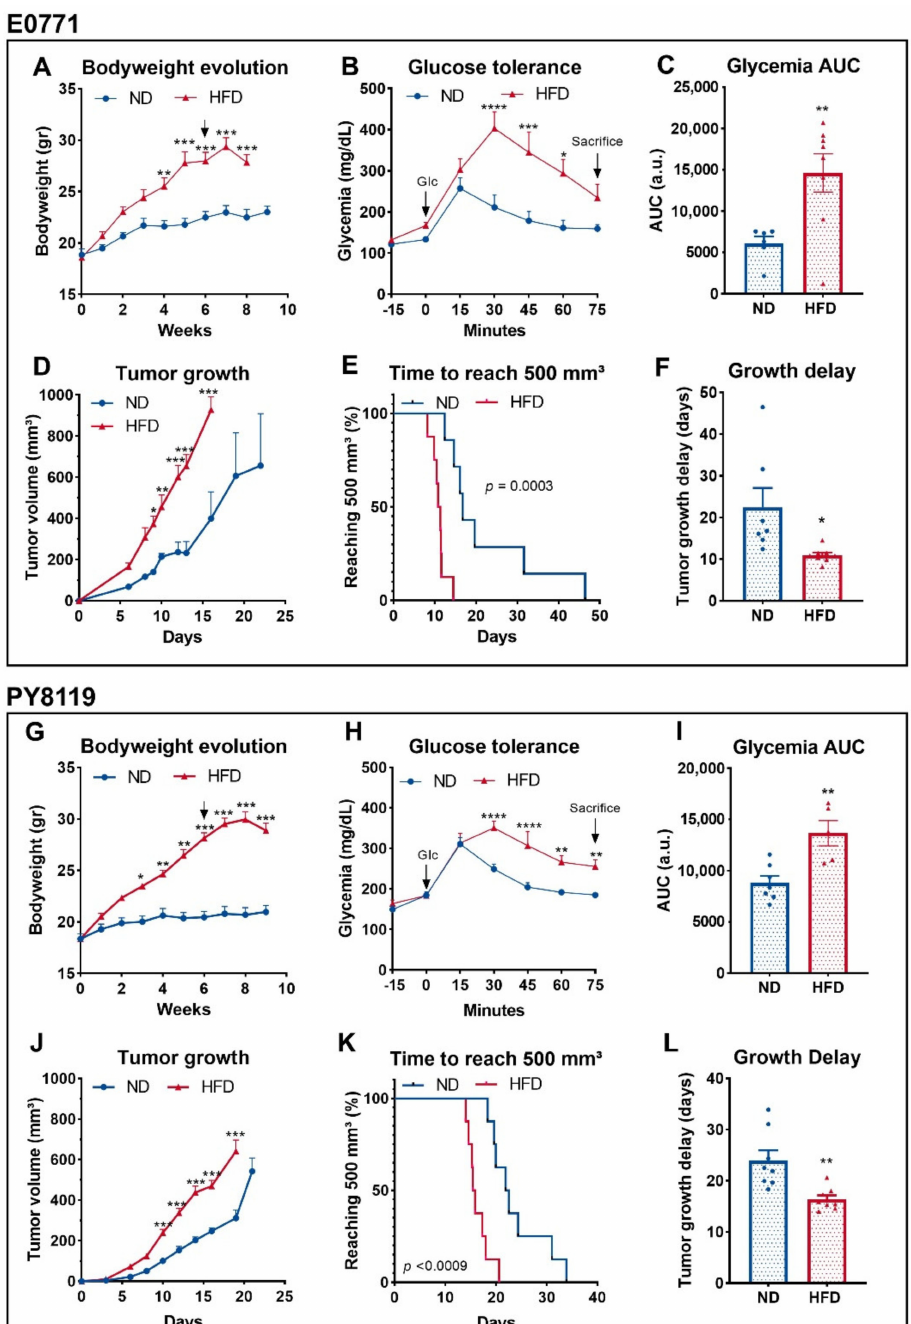
Figure 1. Obese and glucose intolerant mice exhibit bigger breast tumors than lean mice. ( A – F ): E0771 cell line; sample size: n = 7 for ND except for ( C ) n = 6 and n = 8 for HFD. ( G – L ): PY8119 cell line; sample size n = 8 for ND and n = 8 for HFD except ( I ) n = 7 and n = 5, respectively. ( A , G ) Bodyweight evolution under ND and HFD. Arrows indicate tumor growth’s start. ( B , H ) Glycemia levels measured after intraperitoneal U- 13 C glucose (2 mg/g) injection. ( C , I ) Area under the curve calculated from ( B , H ). ( D , J ) Tumor growth evolution. ( E , K ) Survival curve calculated as the time for the tumor to reach 500 mm 3 . ( F , L ) Tumor growth delays calculated as the amount of time needed to reach 500 mm 3 . Statistical analyses: ( A , B , D , G , H , J ) two-way ANOVA followed by Sidak’s multiple comparison test; * p < 0.05; ** p < 0.01; *** p < 0.001.; **** p < 0.0001. ( C , F , I , L ) Unpaired t -test; * p < 0.05; ** p <